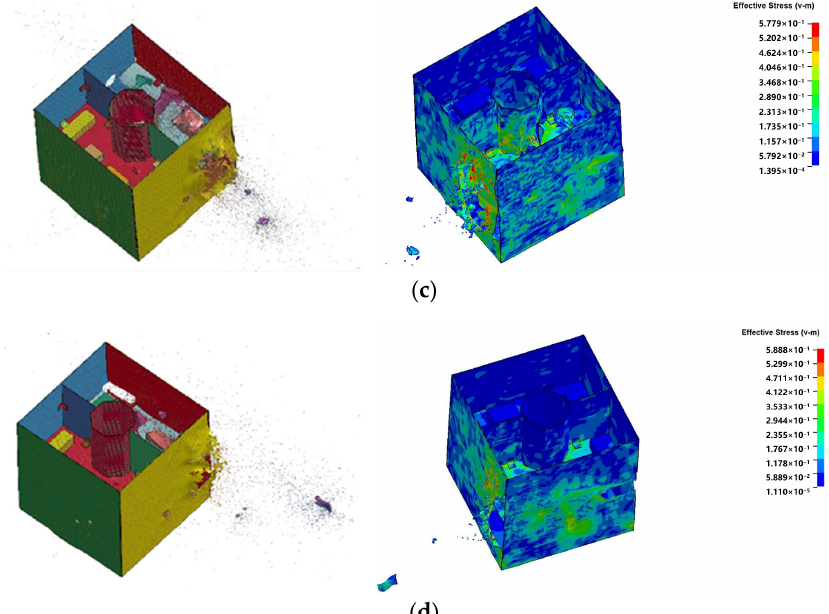
Figure 26. Schematics showing the disintegration of the simulated large-scale satellites 265 μ s after the impact with the hypervelocity space debris at four different positions. ( a ) Test C ( Δ = 0%); ( b ) non-symmetry 1 ( Δ = 20%); ( c ) non-symmetry 2 ( Δ = 50%); ( d ) non-symmetry 3 ( Δ = 100%).